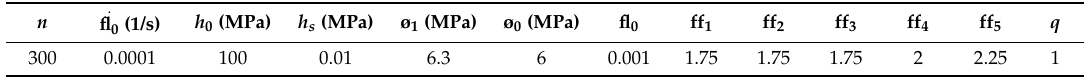
Table 2. Notations of slip systems for FCC crystals.